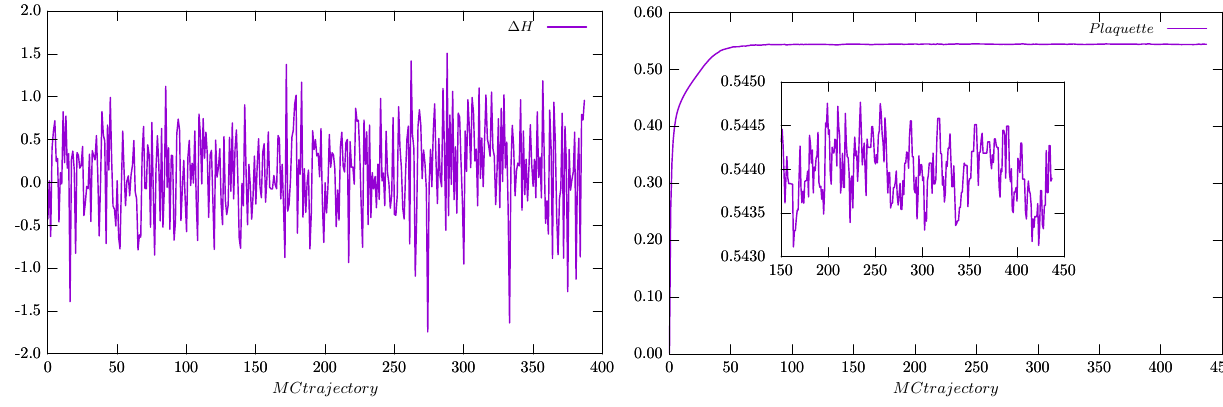
Fig. 1 Plaquette (right) and (cid:23) H (left) as a function of the MD trajectories for β = 10 . 0 and am 4 = am 6 = − 0 . 55